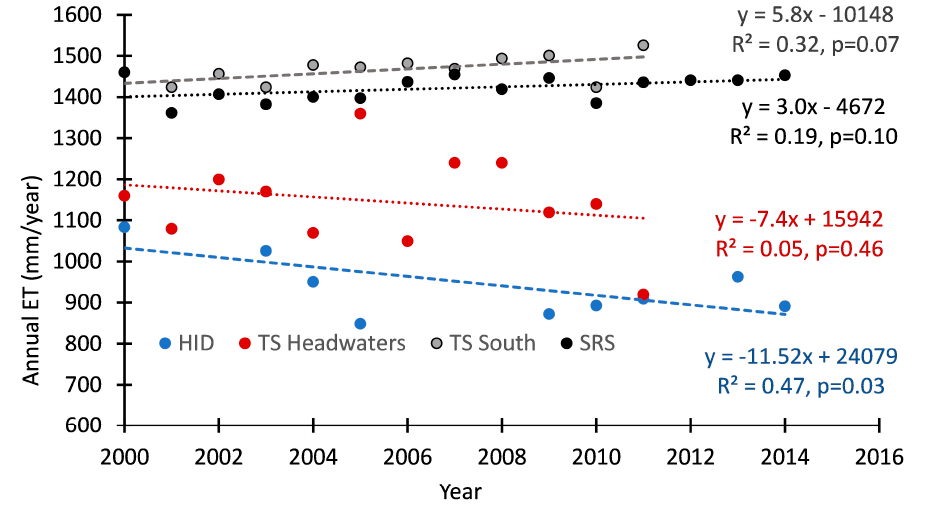
Figure 7. Evapotranspiration (ET) with time as determined from this study for the HID and compared to Taylor Slough (TS) Headwaters [53], Taylor Slough (TS) south [43], and Shark River Slough [54].